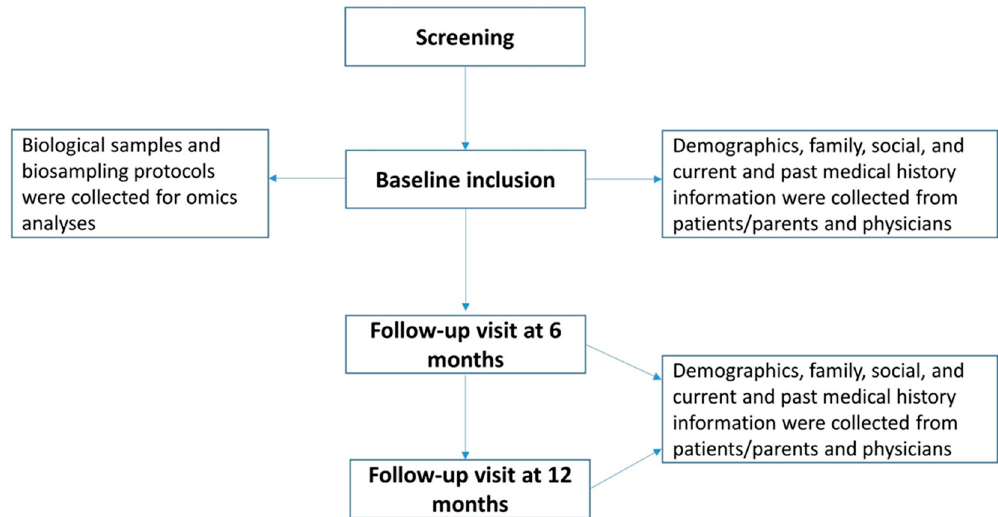
Figure 1. Schematic representation of the study visits schedule. Demographic and current and past medical history assessments were performed at the baseline and follow-up (6 and 12 months) visits. Biosampling protocols (each sample was collected according to a standardized protocol developed for sample tracing, storage, and work-up) and biological specimens were collected from the recruited patients only at the baseline visit.